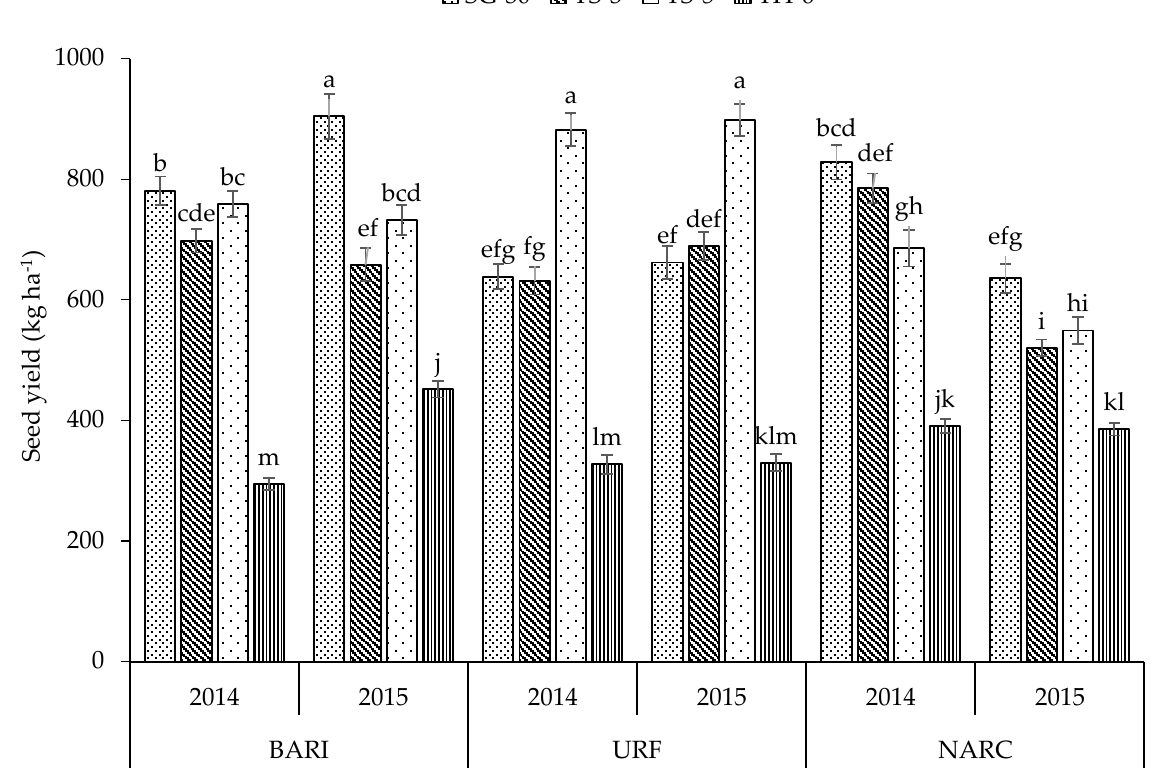
Figure 10. Seed yield (kg ha − 1 ) of four sesame cultivars at three locations during 2014 and 2015 (pooled over micronutrients). The bars indicates standard error ( ± SE) of mean (n = 3). All means are significantly different at p ≤ 0.05.